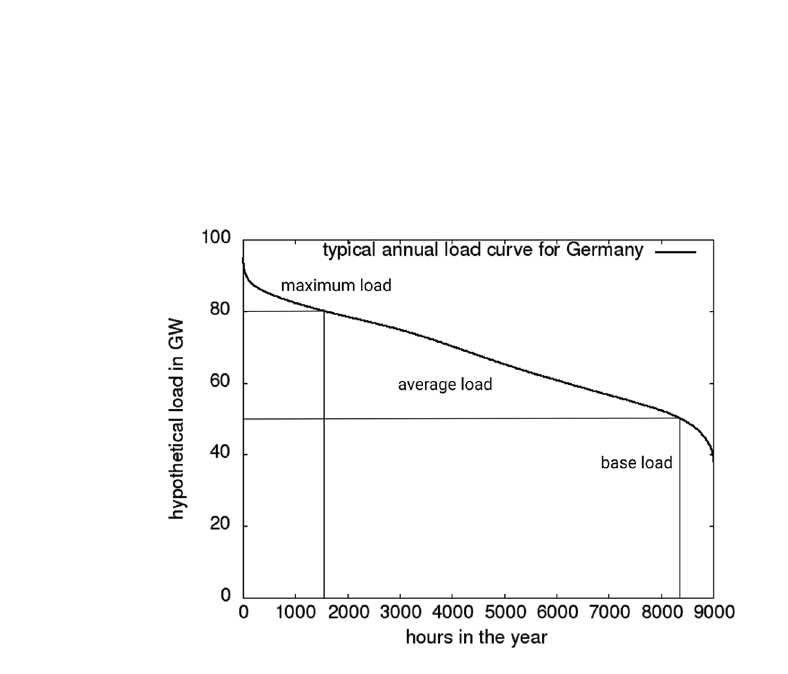
Fig. 1. – Typical annual load curve that displays how much load is required in a given grid ( y -axis) for how many hours in a year ( x -axis). Typical recent annual load curves for Germany can be found for example in [1]. Figure data based on